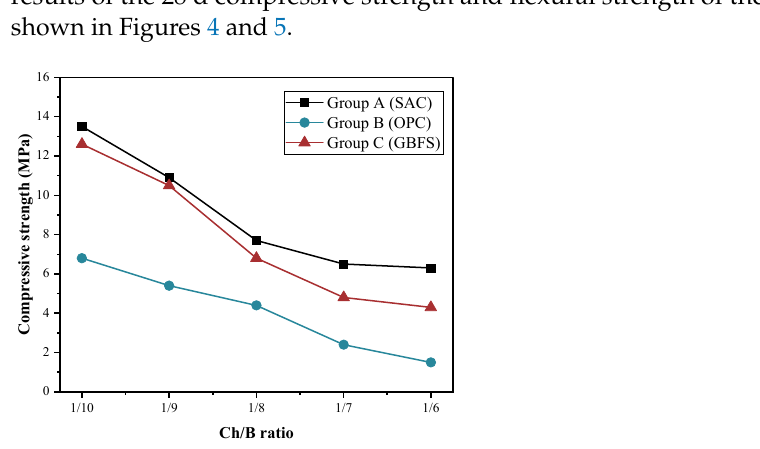
Figure 5. Flexural strength of the different series at 28 d. From Figure 4, it can be seen that the compressive strength of all the mortars in the different groups decreased with the increase in the Ch/B. The main reason might be that the high water absorption of the wood chips weakened the efficient hydration reaction of the cementitious composites. When the Ch/B was certain, the relationship between the magnitude of the compressive strength and each group of specimens was A > C > B. Previous studies showed that the soluble sugars precipitated from wood chips could slow down the hydration reaction rate [39]. To reduce this negative effect, an early strength sulfur aluminate cement was used in group A. The strength results also con ‐ firmed that the sugar precipitated from wood chips had little effect on the hydration re ‐ action of the sulfur aluminate cement, resulting in slightly higher compressive strengths than those in both groups B and C, which indicates that this type of binder affects the compressive strength. Compared to control group B, the higher compressive strength in group C was mainly due to the fact that the alkaline exciter used in group C made the surface of the wood chip rougher, which in turn improved the bonding with the cement. When Ch/B reached 1/10, the strength results of A and C only differed by 0.9 MPa, but the compressive strength of group B was approximately 50% of that of group A. The Ch/B changed from 1/10 to 1/6, and the compressive strength of each group of specimens